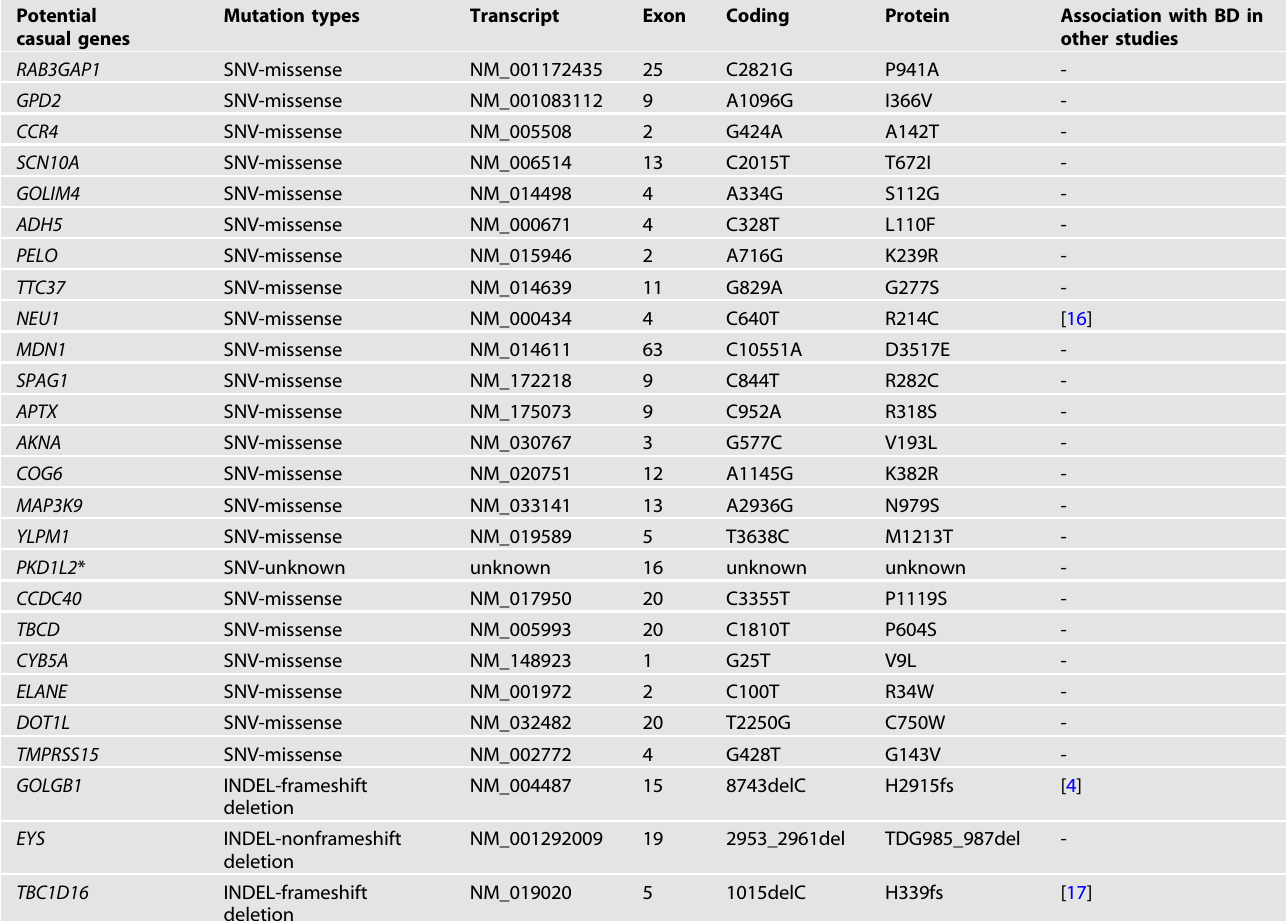
Table 1. Potential gene variations associated with bipolar disorder identi fi ed by